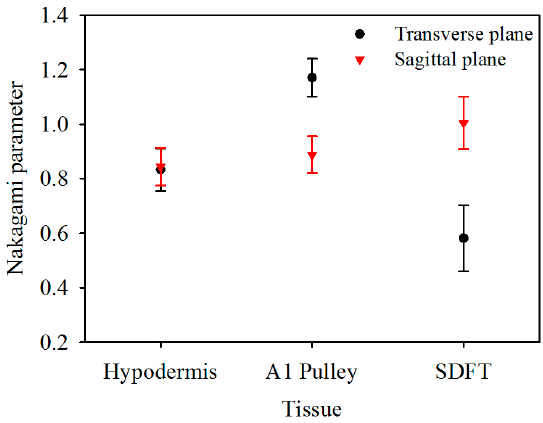
Figure 7. Nakagami parameter of hypodermis, A1 pulley, and SDFT. The error bars represent the standard deviation.